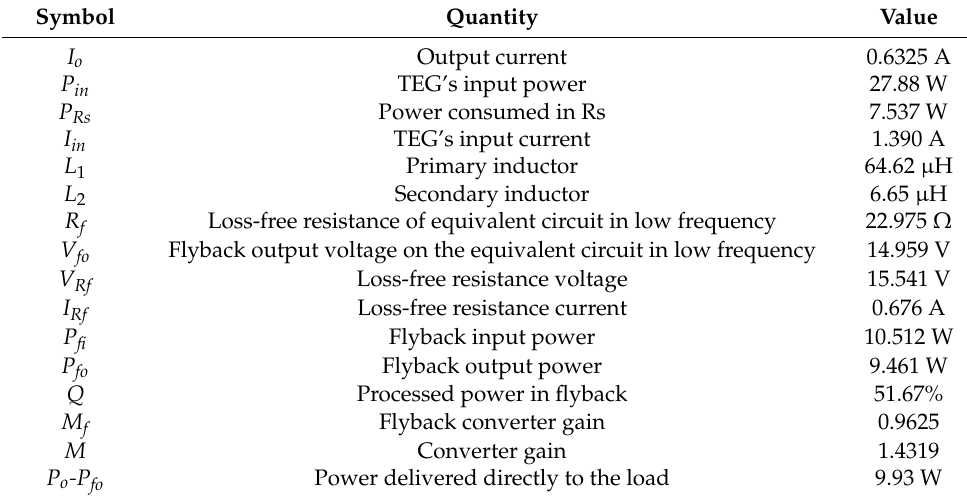
Table 2. Data obtained from model equations.